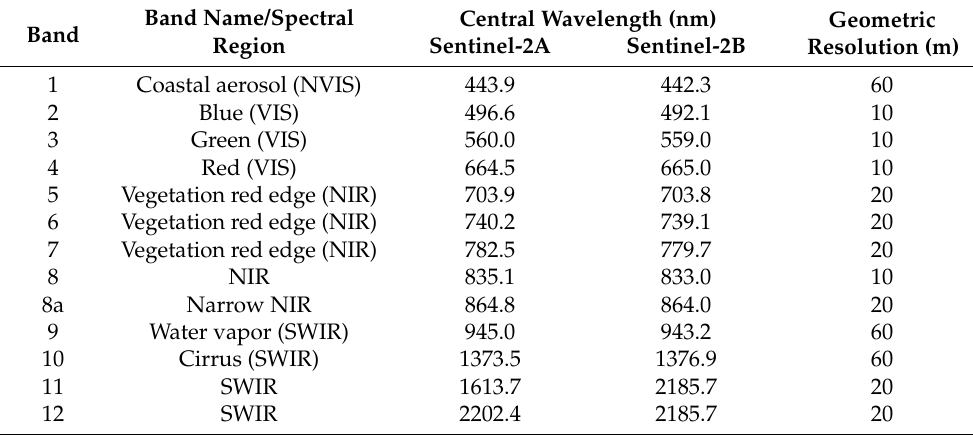
Table 1. Sentinel-2 multispectral instrument (MSI) band